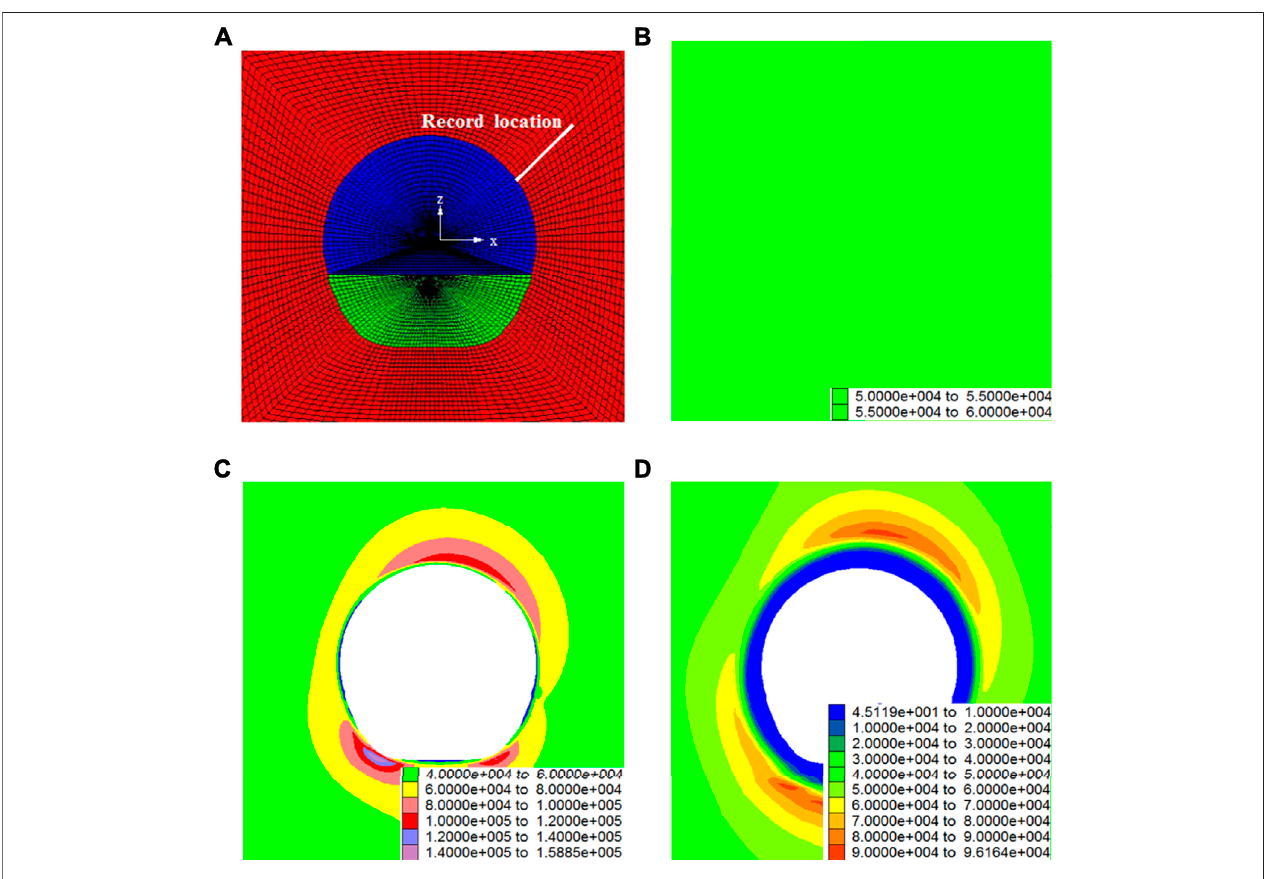
FIGURE 9 | The variation of strain energy due to tunnel excavation (J/m 3 ): (A) Calculation model, (B) Strain energy of initial rock masses before excavation, (C) Strain energy accumulation in surrounding rock masses, (D) residual state of strain energy in surrounding rock masses.